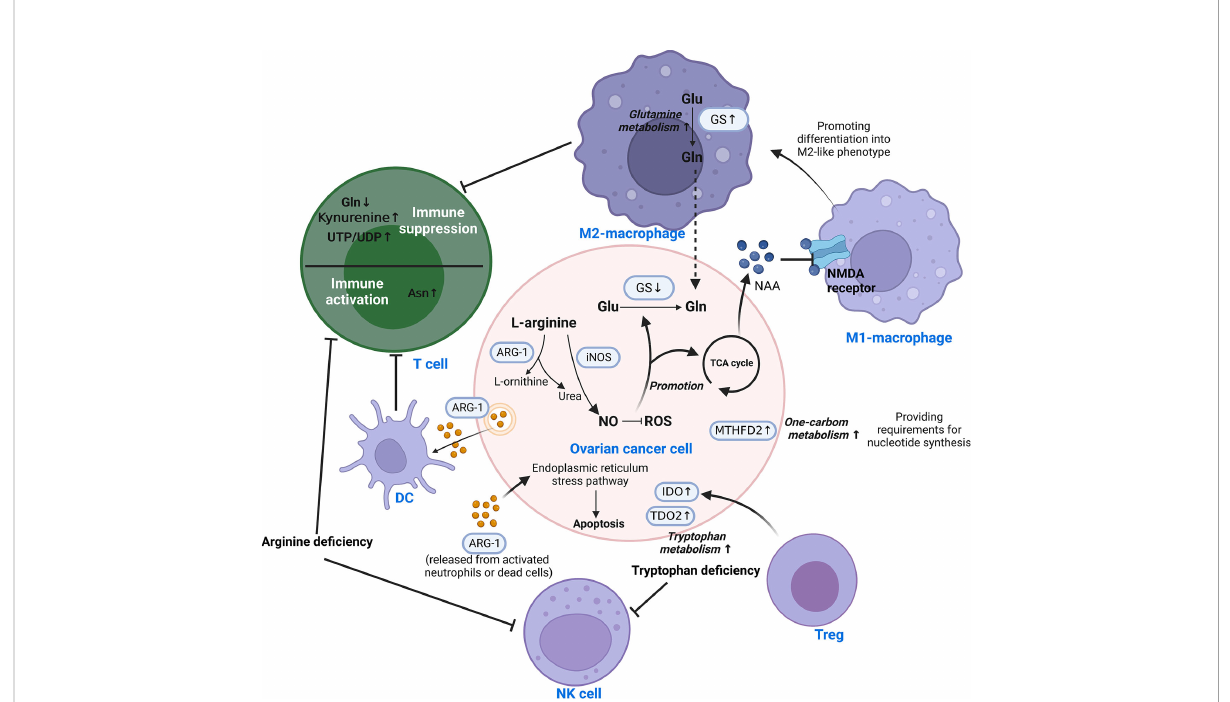
FIGURE 3 Reprogramming of amino acid metabolism in the TIME of ovarian cancer. Amino acid metabolism of ovarian cancer cells and immune cells in TIME is complementarily enhanced by metabolic reprogramming, which is responsible for mediating tumor progression and immune escape. Different cells are interconnected by amino acid metabolites. This involves the reprogramming of glutamine, arginine, tryptophan, aspartate, and one-carbon metabolism. Asn, Asparagine; ARG-1, Arginase-1; DC, Dendritic cell; Glu, Glutamate; Gln, Glutamine; GS, Glutamine synthetase; IDO, Indoleamine 2,3-dioxygenase; iNOS/NOS2, Nitric oxide synthase-2; ROS, Reactive oxygen species; TCA, Tricarboxylic acid; TDO2, tryptophan 2,3-dioxygenase; Teff, effector T cell; Treg, Regulatory T cell; MTHFD2, Methylenetetrahydrofolate dehydrogenase 2; NAA, N- acetylaspartate; NAMD receptor, N-methyl-D-aspartate receptor; NK, Natural killer; NO, nitric oxide; UDP, Uridine Diphosphate; UTP, Uridine